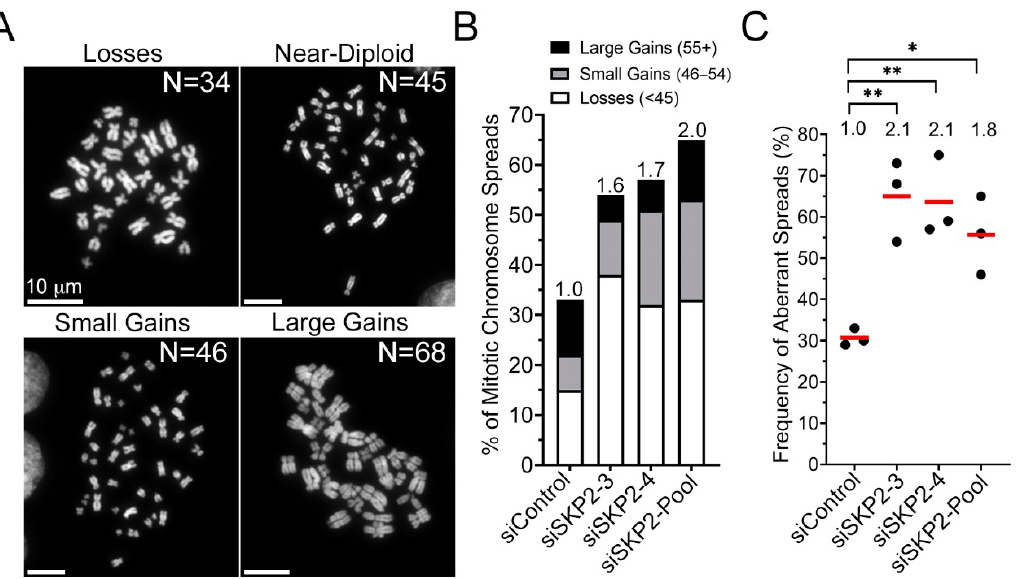
Figure 4. Reduced SKP2 Expression Induces Significant Changes in Aberrant Chromosome Numbers in HCT116. ( A ) Representative high-resolution images of DAPI counterstained mitotic chromosome spreads displaying the modal number of 45 chromosomes, chromosome losses ( ≤ 44), small-scale chromosome gains (46–54), and large-scale chromosome gains ( ≥ 55), including endoreduplication (bottom right), with the total chromosome number (N) indicated in the top right corner of each image. ( B ) Bar graph reveals increases in the percentage of aberrant mitotic chromosome spreads following SKP2 silencing relative to siControl. The fold increase in aberrant spreads is indicated at the top of each column and is presented relative to siControl (N = 3, n = 100 spreads/condition). ( C ) Dot plot presenting the frequency of total aberrant spreads following SKP2 silencing with the relative fold increase indicated (top of each category); red bars identify mean values (Student’s t -test; *, p -value ≤ 0.05; **, p -value < 0.01; N = 3, n = 100